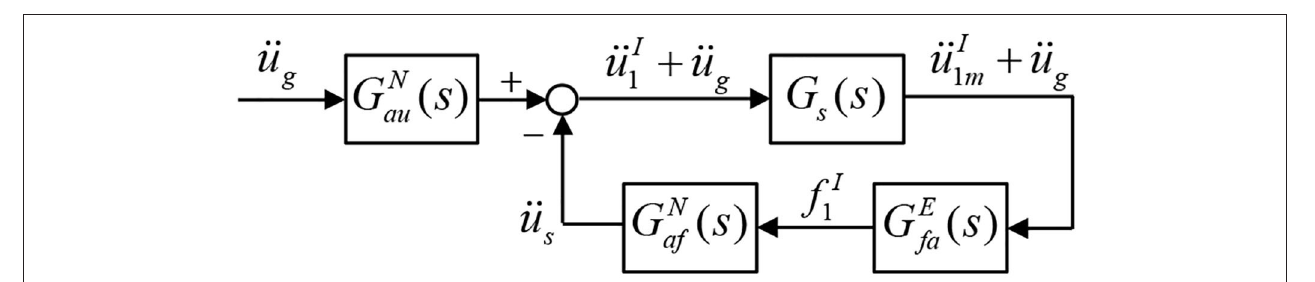
FIGURE 3 | Block diagram of RTHS for a BMD system.